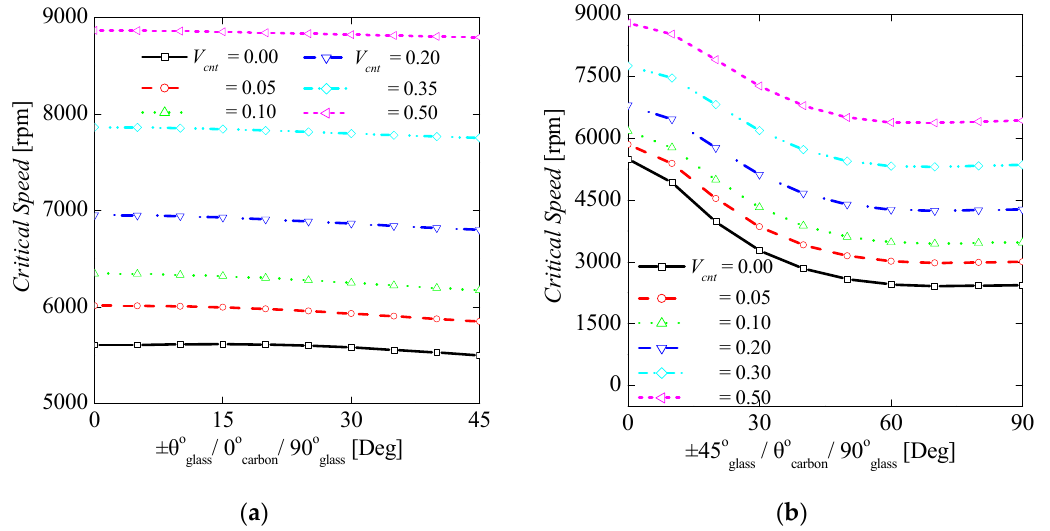
Figure 6. Critical speed as a function of fiber orientation angle ( θ °) for various CNT volume fractions. A hybrid composite drive shaft having four layers stacking of ( a ) [± θ ° glass /0° carbon /90° glass ] and ( b ) [±45° glass / θ ° carbon /90° glass ] was analyzed for length = 1730 mm, radius = 50.8 mm, and wall thickness = 2.032 mm, where the fiber orientation and volumetric concentration of nanoparticles were changed. Figures ( a , b ) show the effect of fiber orientation angle on the critical speed by changing the first two layers and the third (carbon fiber) layer, respectively. The curves show the effect of CNTs volume fractions on the critical speed, computed for CNT volume fractions: 0, 0.05, 0.10, 0.20, 0.35, and 0.50.